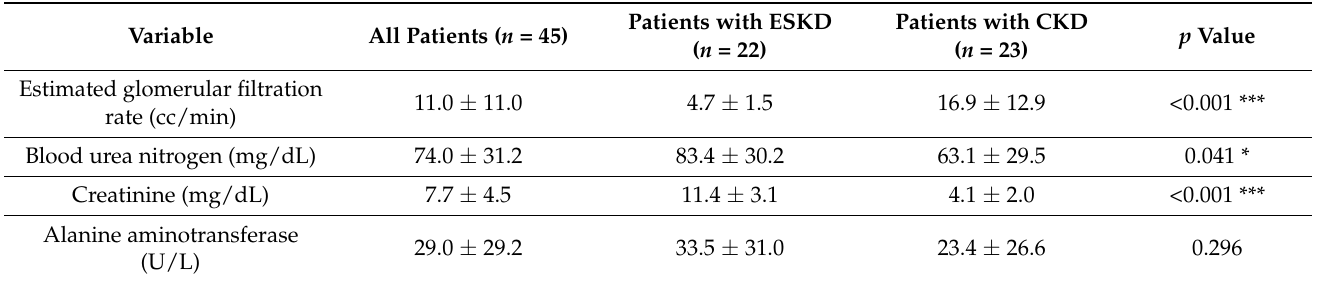
Table 4. Laboratory findings of patients, stratified by renal function as ESKD or CKD ( n = 45).